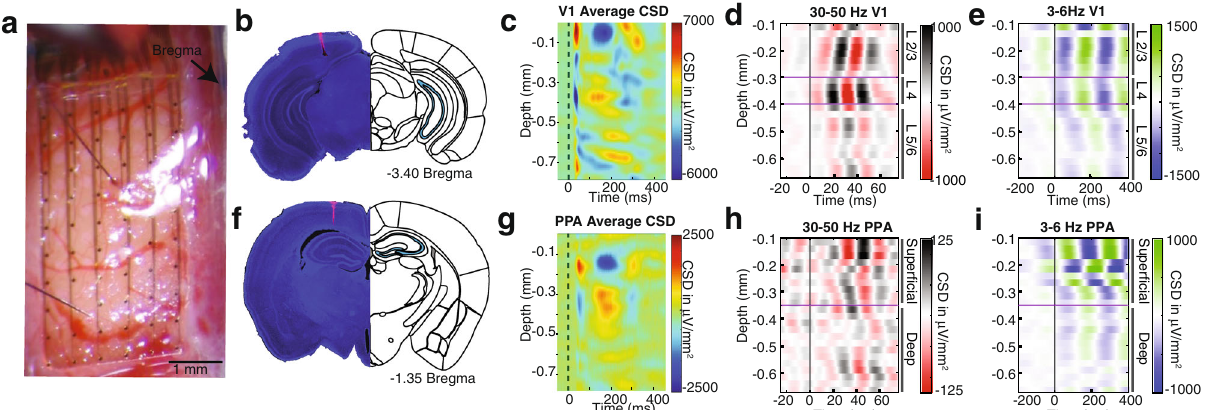
Fig. 4 | Intra-laminar recordings reveal vertical propagation pattern of waves. a Photograph of 64 channel electrocorticography grid with two 32 channel pene- trating laminar probes placed in through holes in the grid into V1 and PPA. b Histological veri fi cation of laminar electrode localization in V1. Outline adapted from the Allen Mouse Brain Atlas and Allen Reference Atlas — Mouse Brain 88,90,91 . c Currentsourcedensity(CSD)inV1averagedovertrialsandmice. d V1CSD fi ltered at 30 – 50Hz and averaged across trials in a representative mouse. 30 – 50Hz oscil- lations originate in layer IV and then propagate to super fi cial and deep cortical layers. In d , e purple lines show approximate location of layer IV de fi ned by the